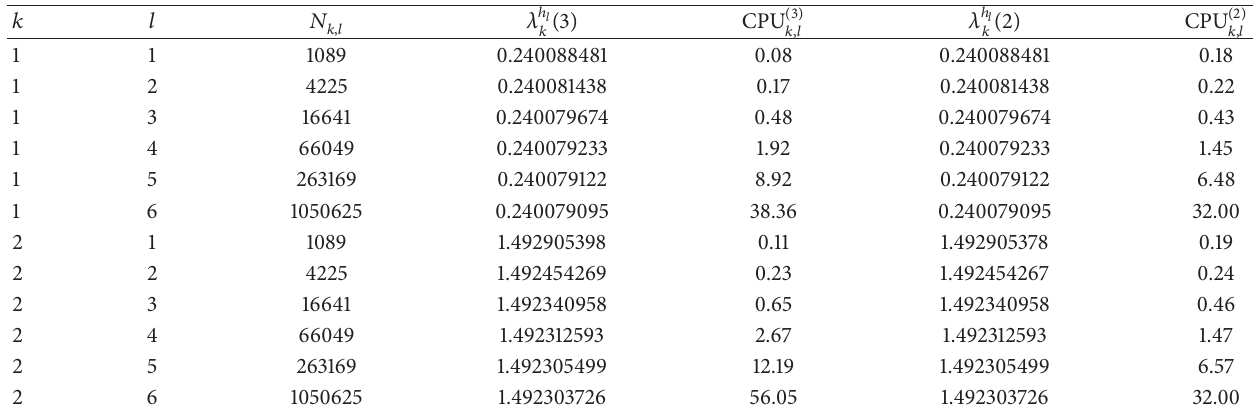
Table 4: The results of Example 4 on Ω = [0,1] × [0, 1] .